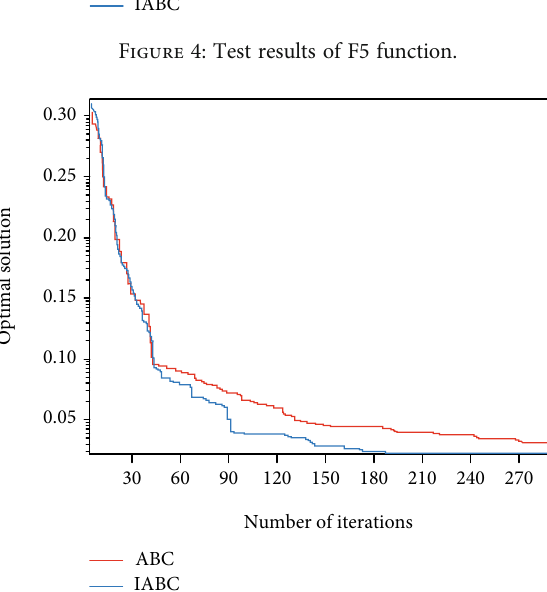
Figure 4: Test results of F5 function.